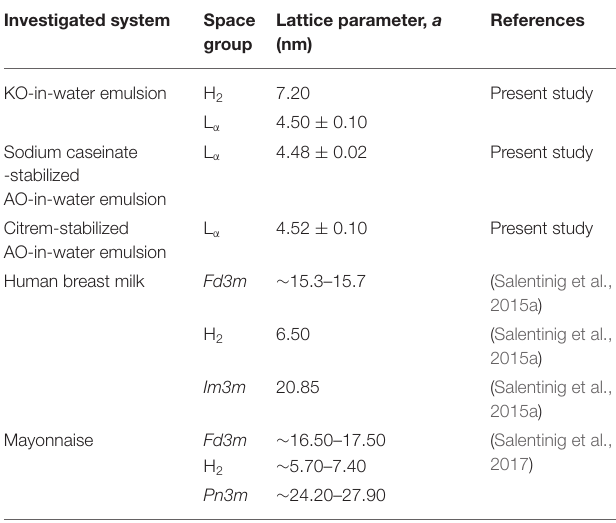
TABLE 3 | Structural parameters of lyotropic lamellar and non-lamellar liquid crystalline phases identified in digested KO and AO emulsions at 37 ◦ C and selected published findings for digested human breast milk and mayonnaise as determined from SAXS